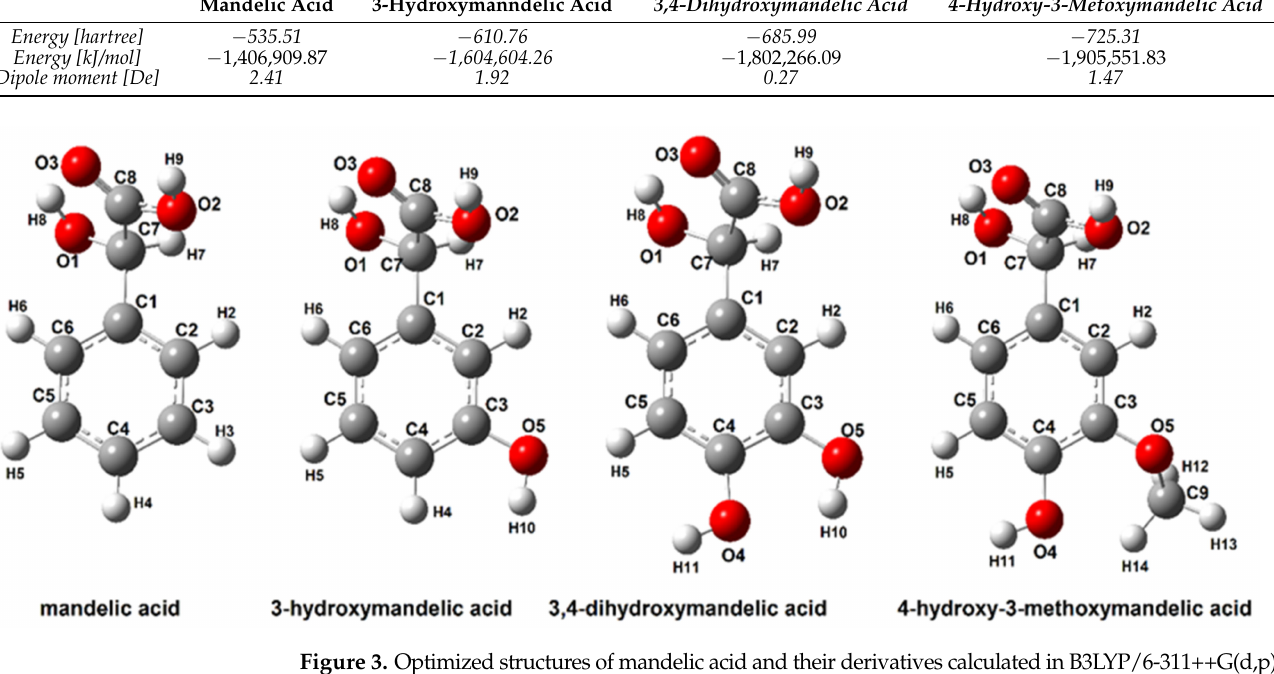
Figure 3. Optimized structures of mandelic acid and their derivatives calculated in B3LYP/6-311++G(d,p). 3.2.2. Bond Dissociation Enthalpy, Ionization Potentials, Proton Dissociation Enthalpies, Proton Affinities and Electron Transfer Enthalpies for Mandelic Acid and Its Derivatives BDE, IP, PDA, PA and ETE were calculated using the abovementioned equations. In Table 2, the results are presented. Table 2. Thermodynamical parameters of mandelic acid and its derivatives in vacuum, water